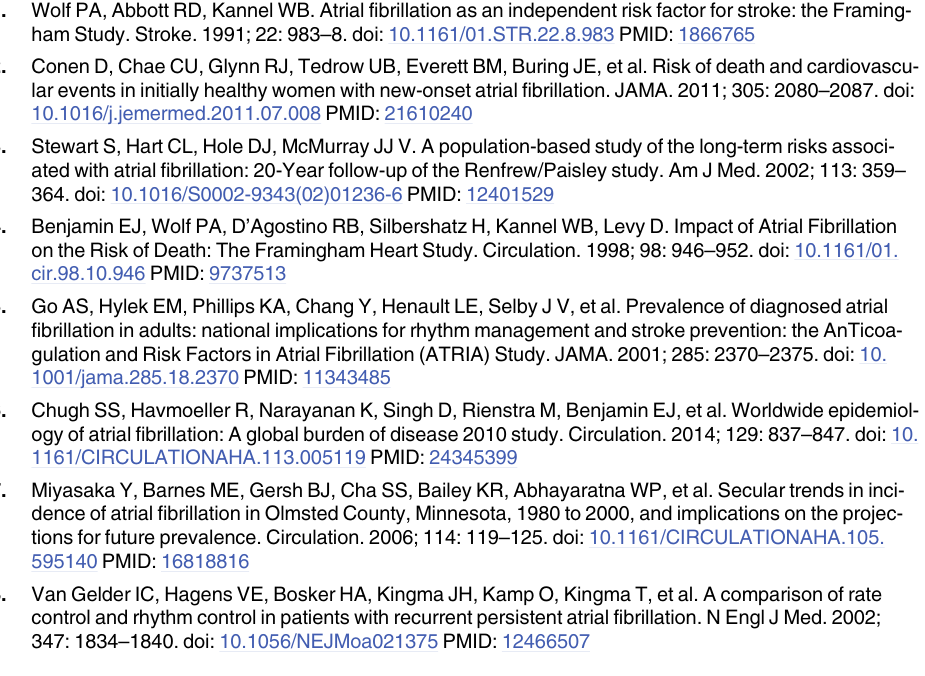
S6 Fig. Boxplots of microarray gene expression in control[30] population grouped based on hours from symptom onset. Boxes extend from the 25 th to the 75 th percentile, with the horizontal line representing the median. Outliers are identified as samples with an expression value 1.5 times more or less than the interquartile range. A) Expression of SLC25A20 . B) Expression of PDK4 . S1 Table. Results of logistic regression model for AF status including biomarkers. A logistic regression model was constructed for rhythm status. The model included only NT-proBNP, SLC25A20 and PDK4 . S2 Table. Results of logistic regression model for AF status including biomarkers and LA maximum volume. A logistic regression model was constructed for rhythm status. The model included NT-proBNP, SLC25A20 , PDK4 and left atrial maximum volume. S3 Table. Demographics for the independent validation in participants with successful car-